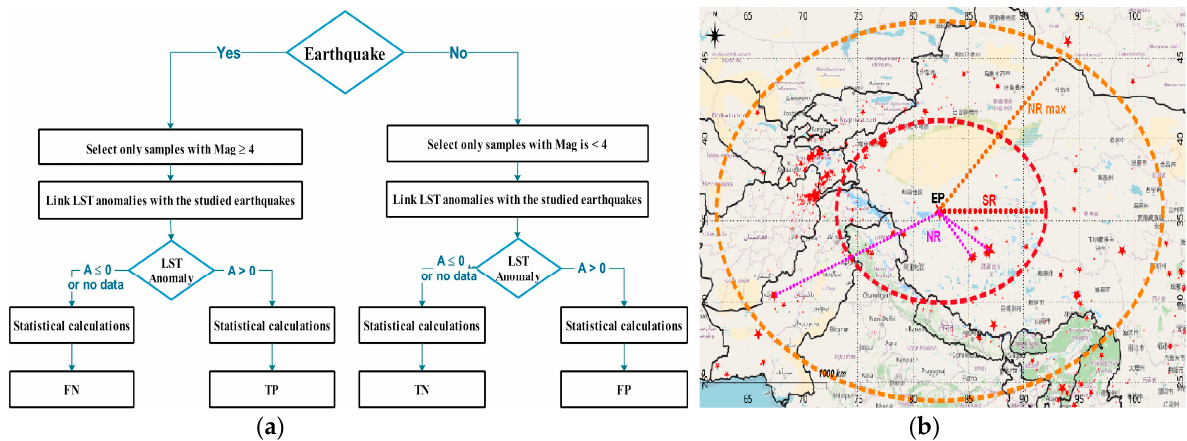
Figure 3. ( a ). The flowchart of LST anomalies and earthquakes association, ( b ). Map showing the epicenter (EP), SR, NR, and the NR max of the ID7854 earthquake with a Mw = 6.7, a SR = 760 km NR max = 1520